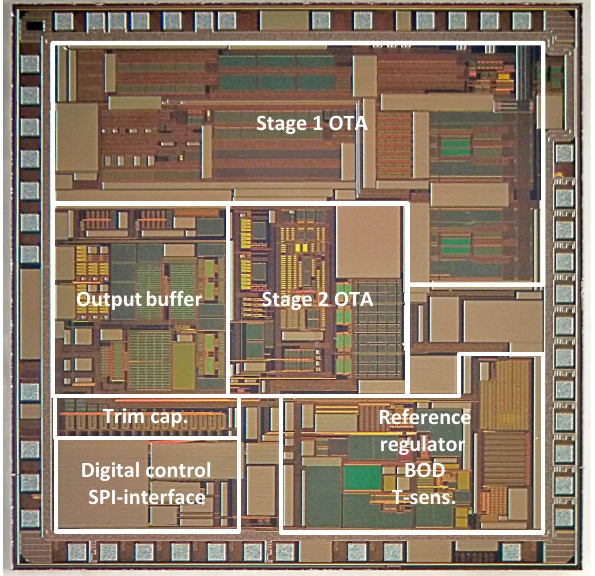
Figure 6. Photograph of the